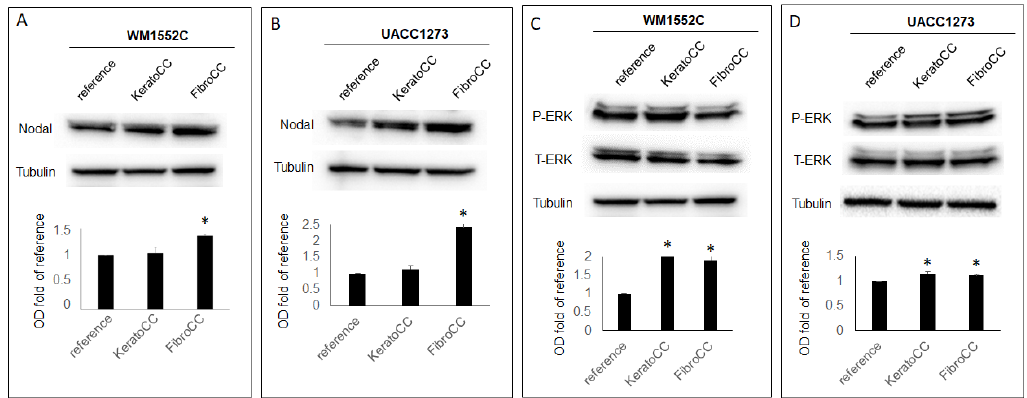
Figure 3. Poorly aggressive melanoma cells show increased expression of Nodal and increased ERK1/2 activity after exposure to normal skin cells. Results from WB and densitometric analysis of WB bands show Nodal expression gradually increasing to significant levels after co-culture of WM1552C ( A ) and UACC1273 ( B ) with normal human epidermal keratinocytes (KeraCC) and normal dermal fibroblasts (FibroCC) compared to reference cells. The same co-culture experiment showed an increase in ERK1/2 phosphorylation in both WM1552C ( C ) and UACC1273 ( D ) (* p < 0.05). Results are representative of at least two independent experiments, each performed in triplicate.